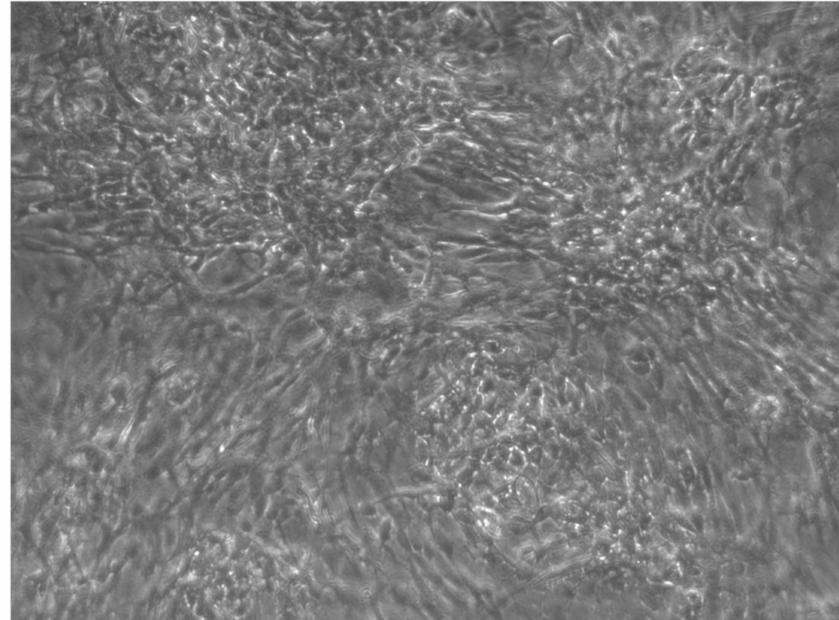
Figure 10. CTR4#5 P19 showed a di ff erent structure since the first days of di ff erentiation; this image shows at 28 days how the phase microscope structure was di ff erent from the other clones.